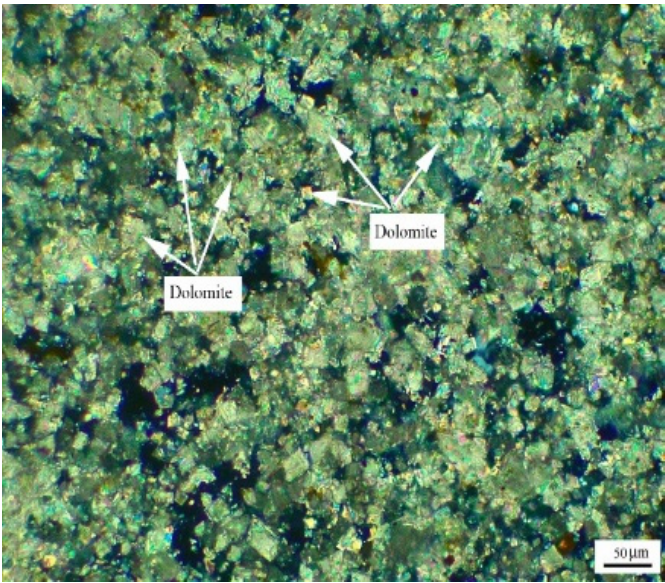
Figure 7. Distribution of dolomites in Triassic rock DJY.